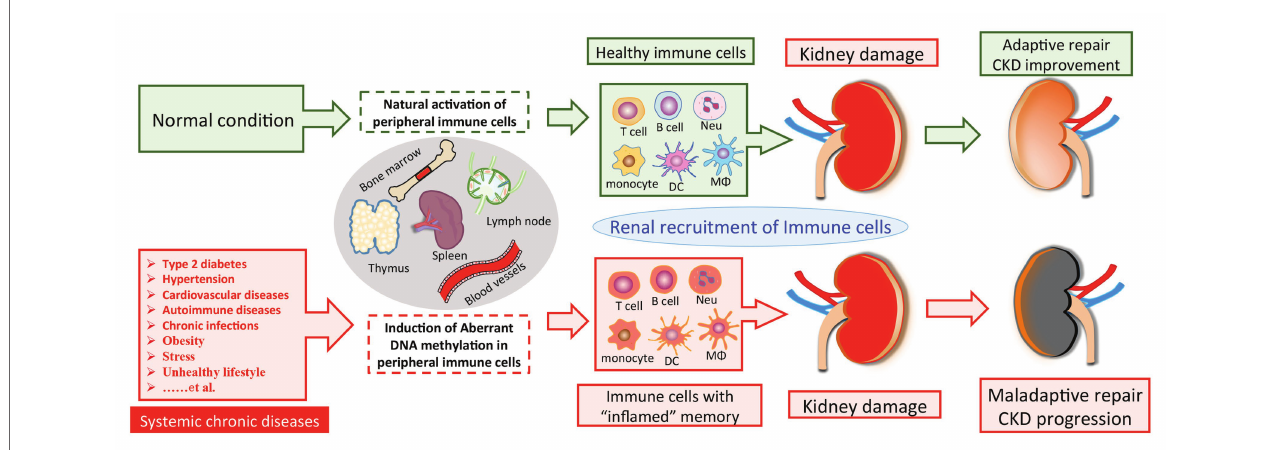
FIGURE 1 | A model of DNA methylation in peripheral immune cells in the pathogenesis of CKD development. Chronic pathogenic conditions induce aberrant DNA methylation in peripheral immune cells, leading to enhanced activities of pro-inflammatory genes and a cell-type switch toward “inflamed” effectors. Normally, renal recruitment of circulating immune cells can facilitate adaptive repair and improve the outcome of kidney damage. On the other hand, peripheral immune cells with “inflamed” DNA methylation profile may constantly migrate into the diseased kidney and overact tissue inflammation, which consequentially results in maladaptive repair and CKD progression. CKD, chronic kidney disease; Neu, neutrophil; DC, dendritic cell; M ϕ ,